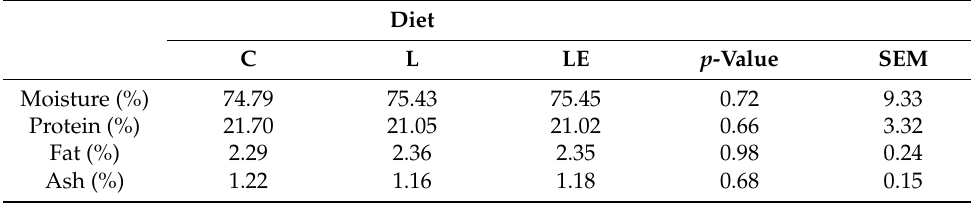
Table 2. Effect of three experimental diets on meat quality chemical composition at time point 0.